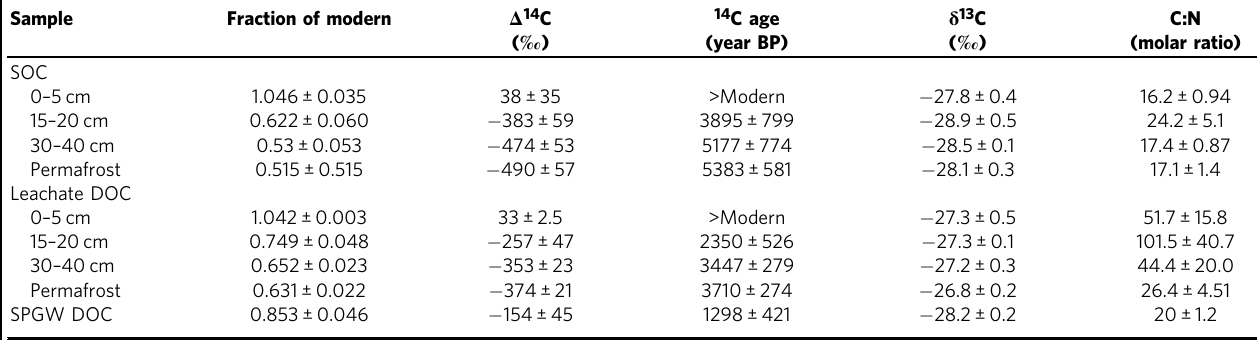
Table 2 Radiocarbon and stable carbon isotopic compositions and C:N ratios in SOC, leachable soil DOC, and SPGW DOC.